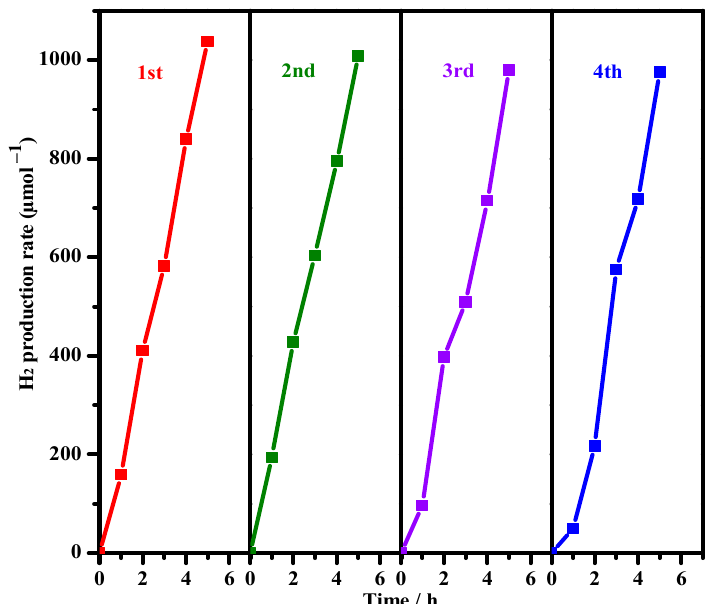
/ PPy-RGO-0.25 during the recycled